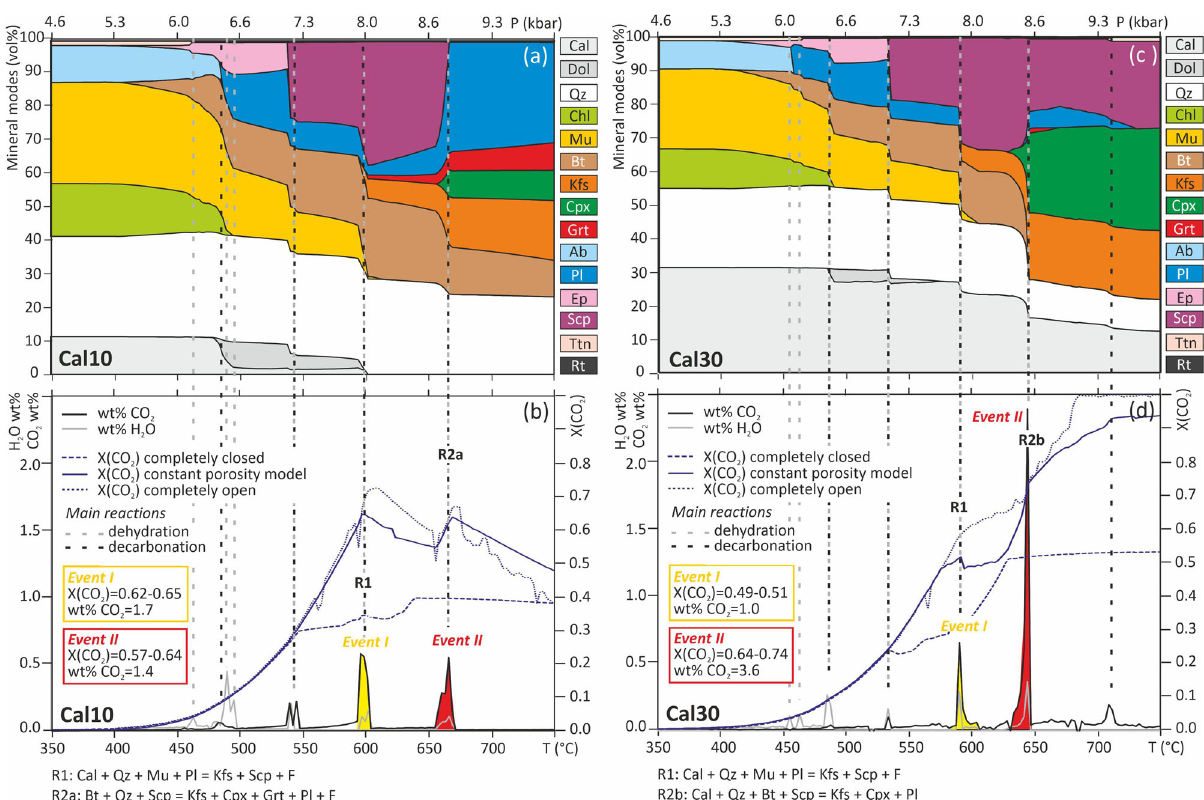
Fig. 1 Modal variations and wt% of CO 2 and H 2 O released during prograde metamorphism of Cal10 and Cal30 bulk compositions. a , c Mode box changes in calculated mineral proportions (vol%, fl uid excluded) during prograde metamorphism of sediments initially containing ( a ) 10 vol% of calcite (Cal10) and ( c ) 30 vol% of calcite (Cal30) along the modeled internally buffered P/T – X (CO 2 ) paths. b , d Loss (wt%) of CO 2 (black line) and H 2 O (gray line) relative to the initial CO 2 and H 2 O content in the solids, and X (CO 2 ) of the fl uid (blue lines) released during prograde metamorphism of Cal10 ( b ) and Cal30 ( d ), along the same internal buffered P / T - X (CO 2 ) path as in ( a ) and ( c ). Events I (yellow) and II (red) refer to the main events of CO 2 production, as discussed in the text. Dashed lines highlight the main dehydration and decarbonation reactions, corresponding to abrupt consumption and/or complete disappearance of hydrous and CO 2 -bearing minerals. Reactions corresponding to the event I (R1) and event II (R2a, R2b) are speci fi